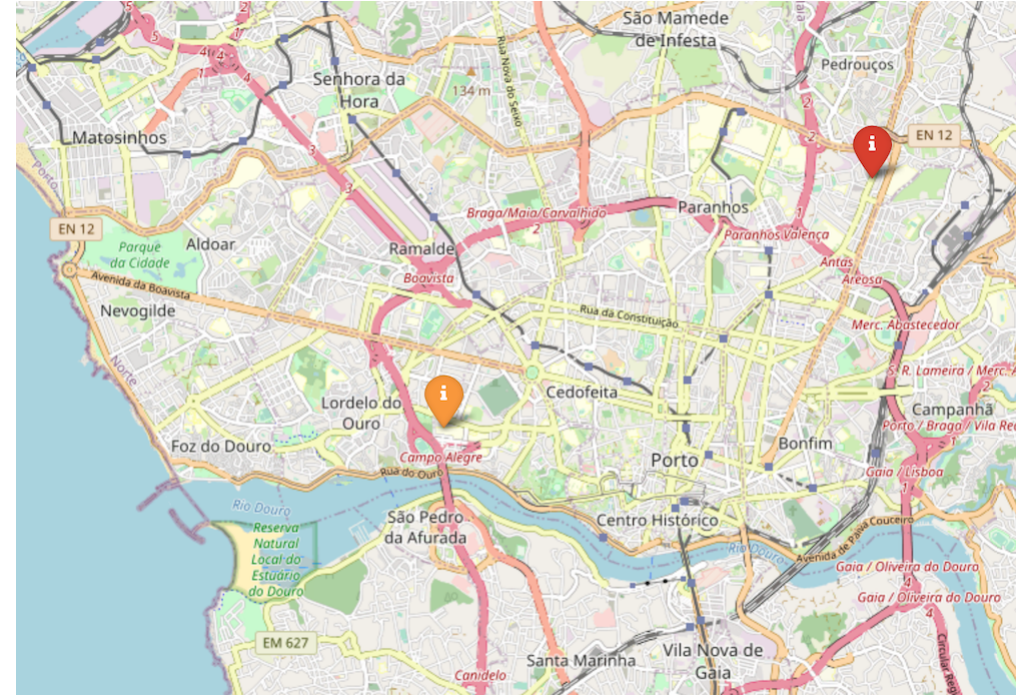
Figure 11. A new alarm is being reported in a different location, indicating noise, smoke and heating instance